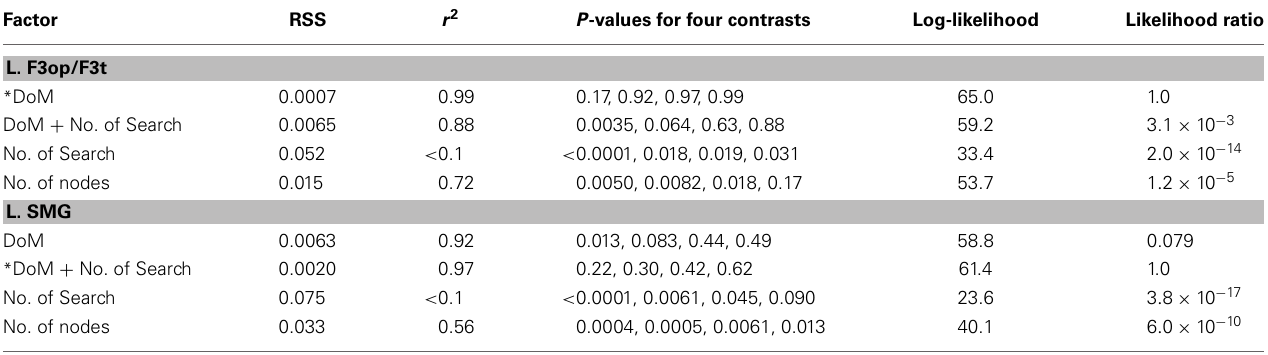
Table 2 | Fittings and likelihood of various models tested in Ohta et al. (2013). Factor RSS r 2 P -values for four contrasts Log-likelihood